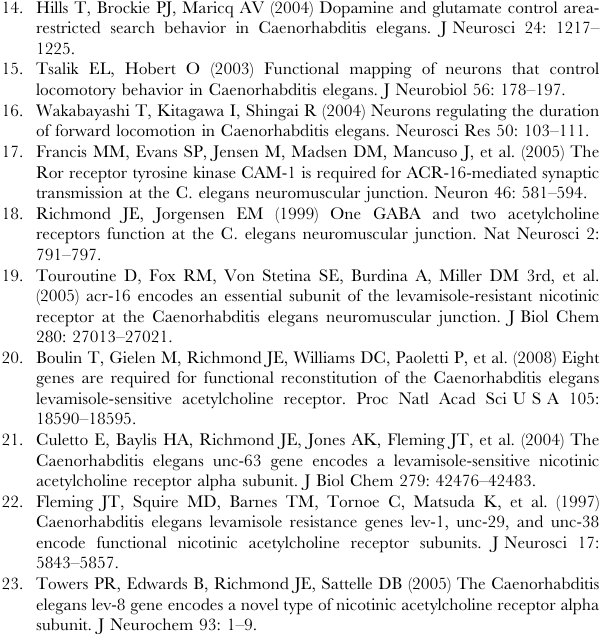
Figure S5 The frequency of endogenous excitatory post-synaptic currents is not affected by L-AChR( gf ) expression. ( A ) Endogenous excitatory synaptic events recorded from body wall muscles of wild